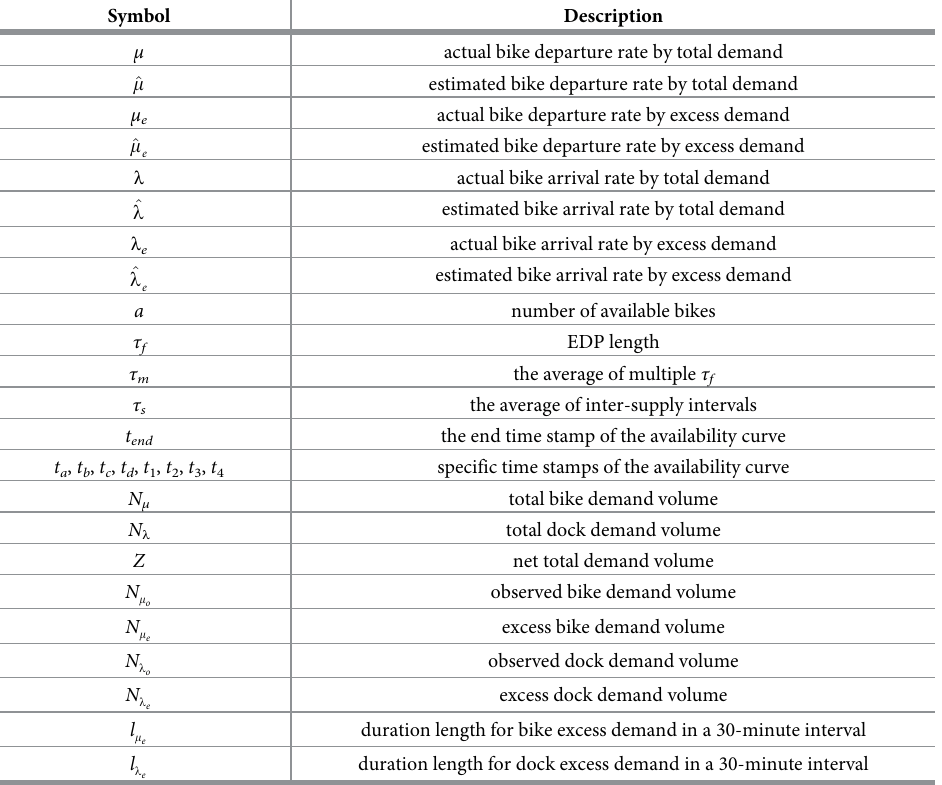
Table 1. A list of notations used through the